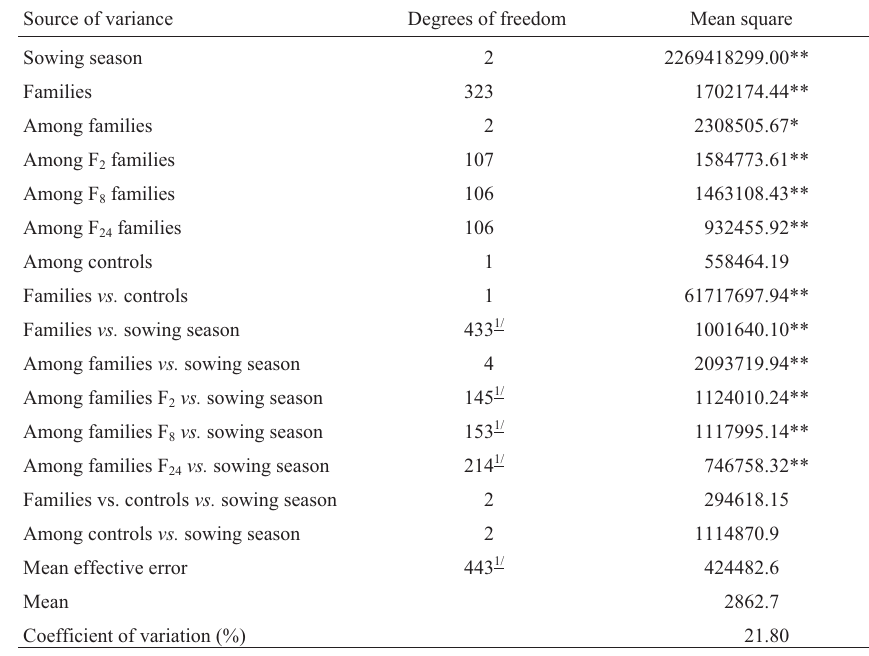
Table 1 - Summary of the joint analysis of variance for yield (kg/ha) of families derived from F 2 , F 8 and F 24 plants in three sowing seasons, July/2001, November/2001 and March/2002.